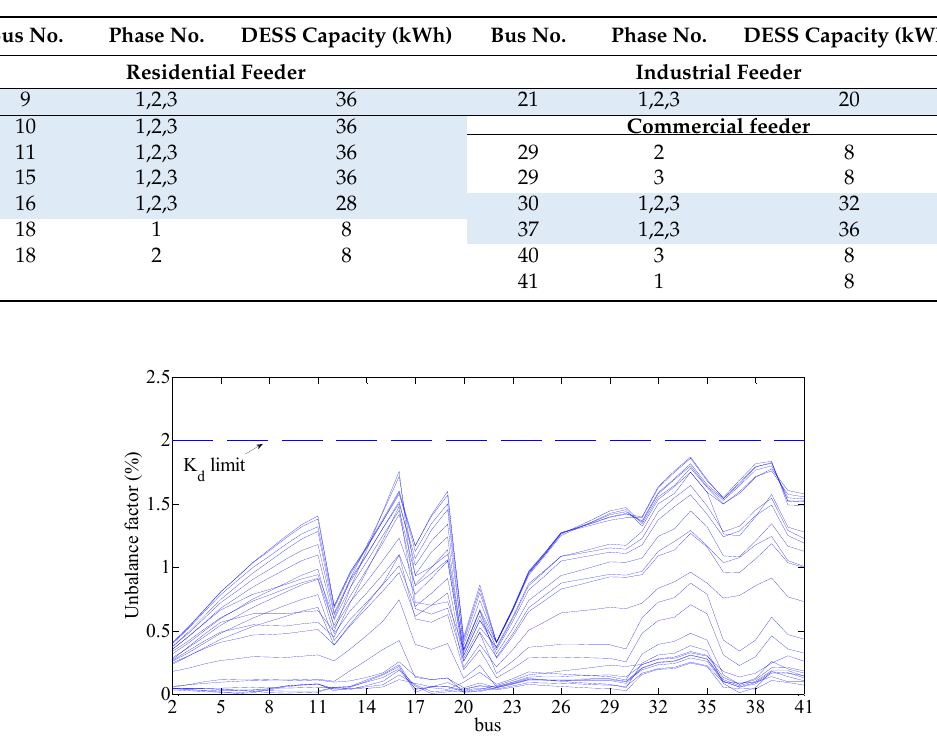
Figure 10. Case Study 3: Unbalance factor at each hour of the last typical day.